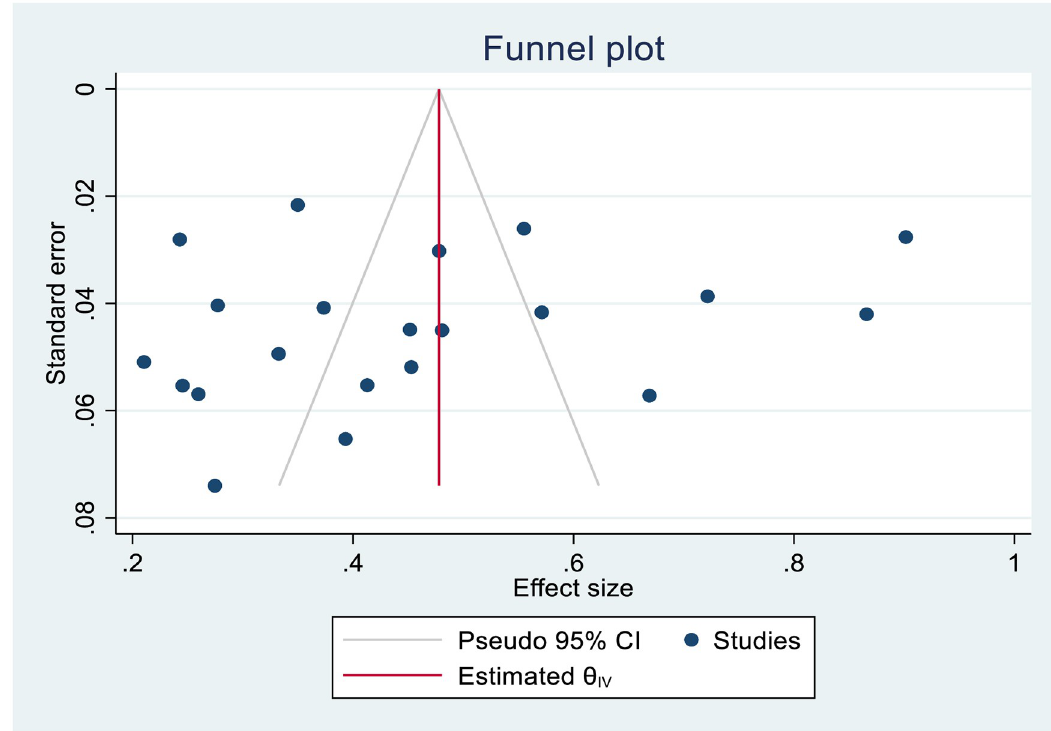
Fig 3. Assessment of publication bias.